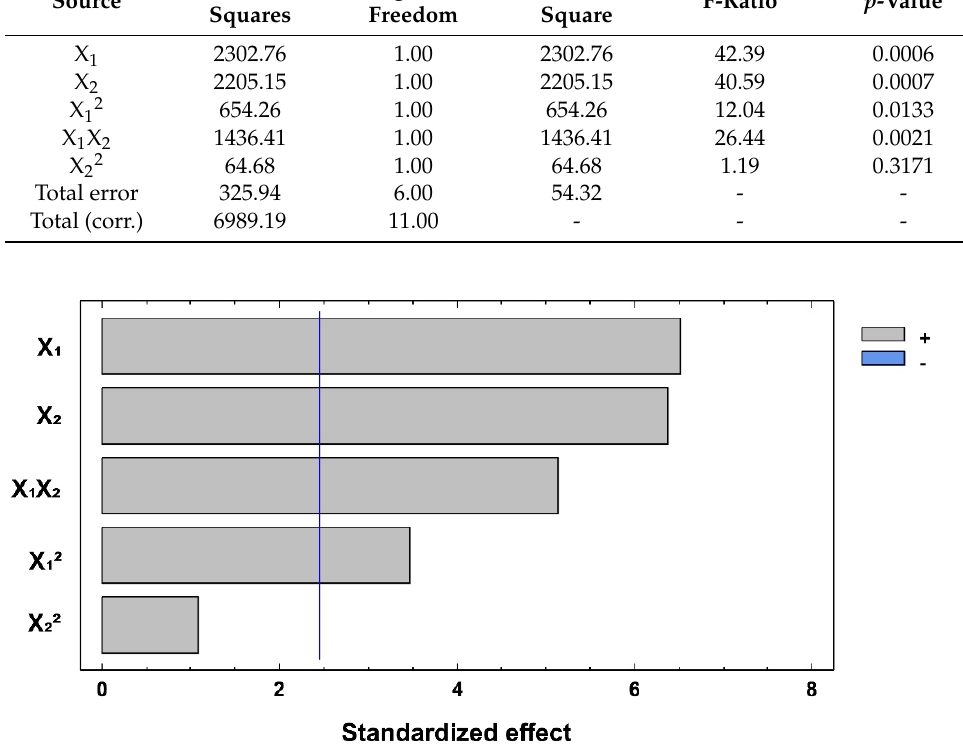
Figure 2. Pareto chart for arsenic sulphide precipitation.